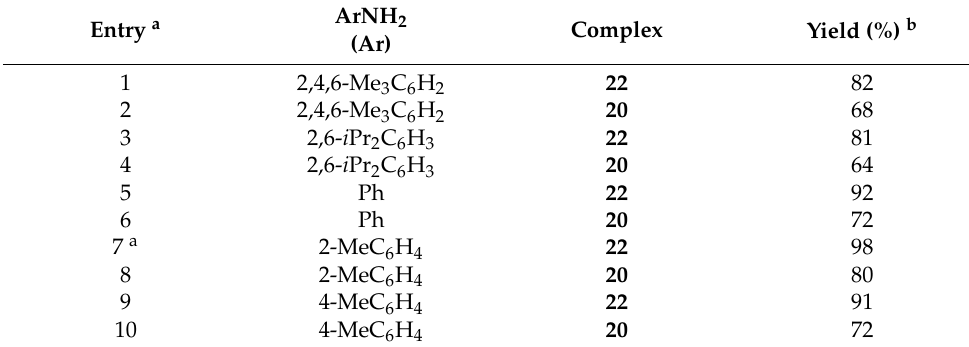
concentration of Au active sites), 2 mol% AgBF 4 , 1 mL of MeCN at 90 °C, 6 h. b Yields determined by GC using anisole as internal standard.